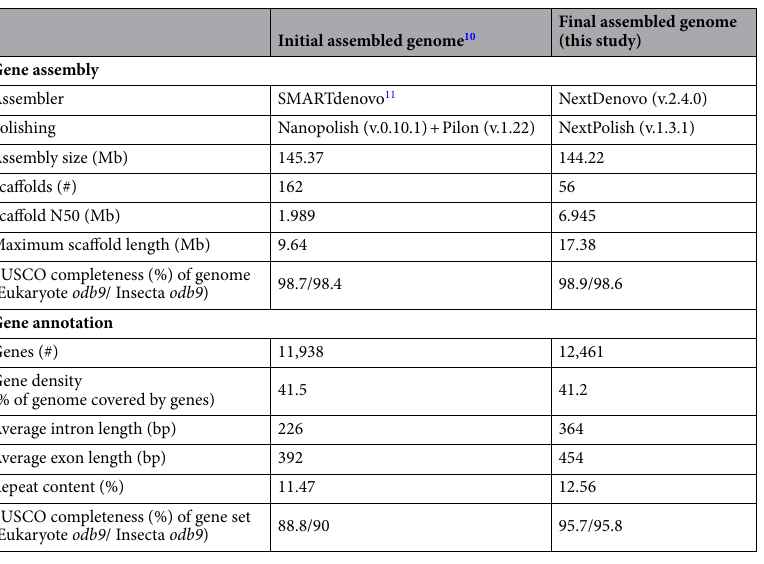
Table 1. Comparison of assembly and annotation statistics for the new and previously reported P. steinenii